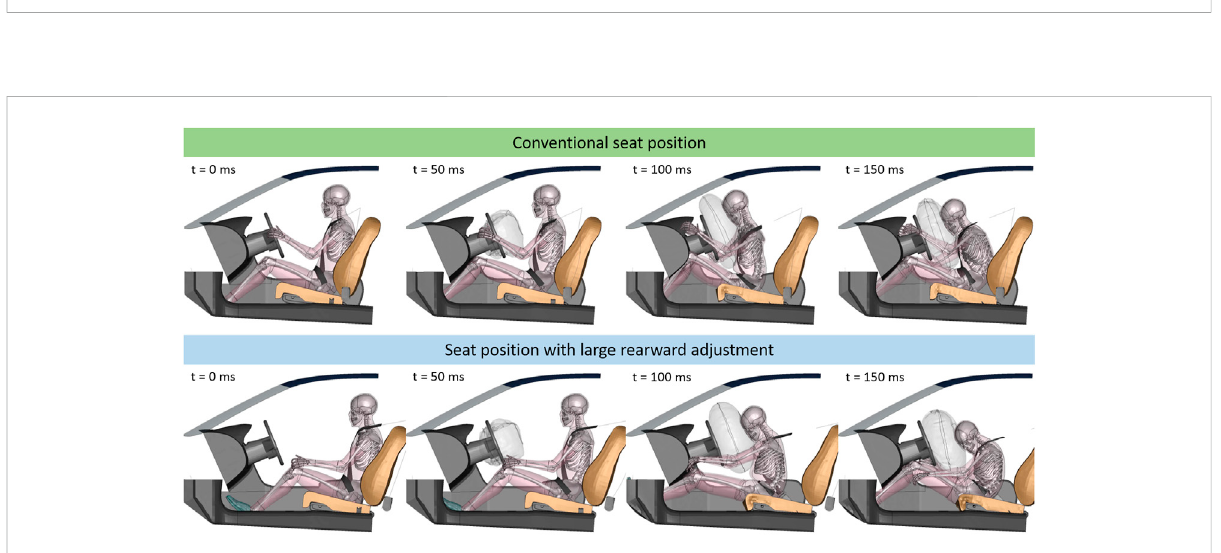
FIGURE 4 Still frames of case 557 (delta-v: 47 km/h). Top row shows kinematics for conventional seat position (21.8 mm behind max. forward position), lower row shows kinematics for seat adjusted 237.3 mm towards the rear. For visualization purposes, parts of the interior and HBM have been